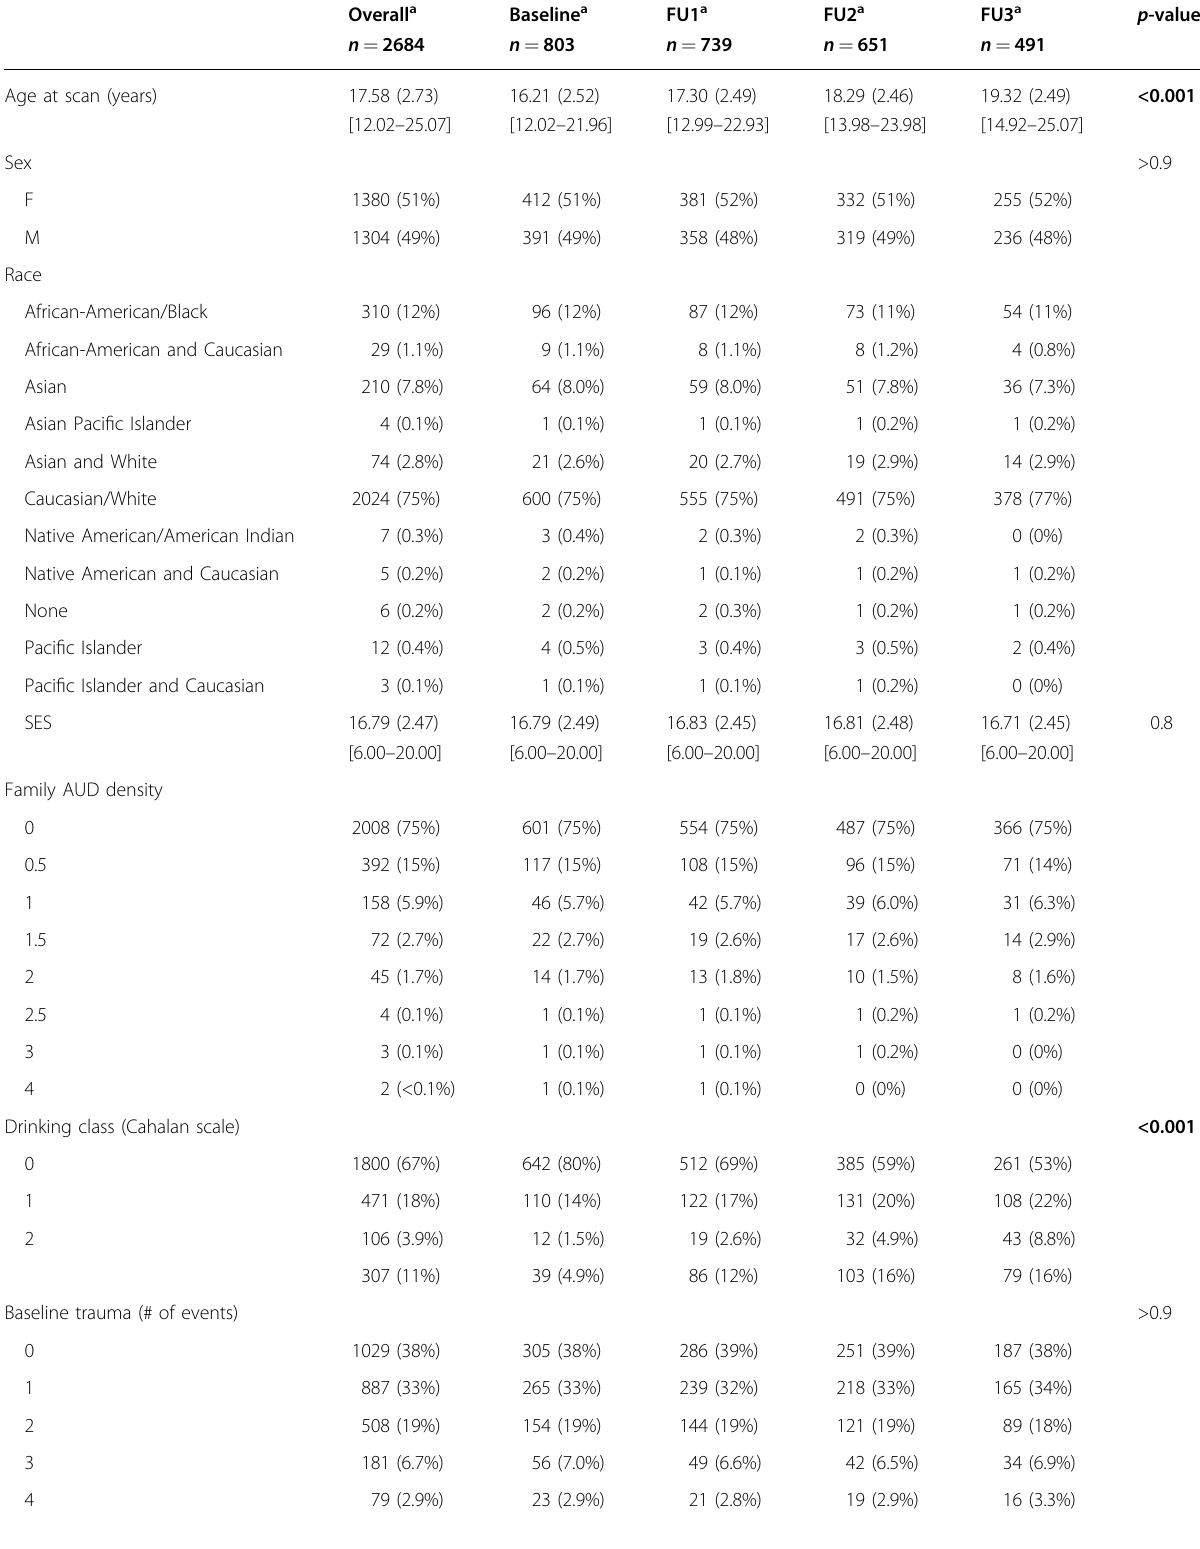
Table 1 Demographic characteristics at baseline and follow-ups (FU) 1, 2, and